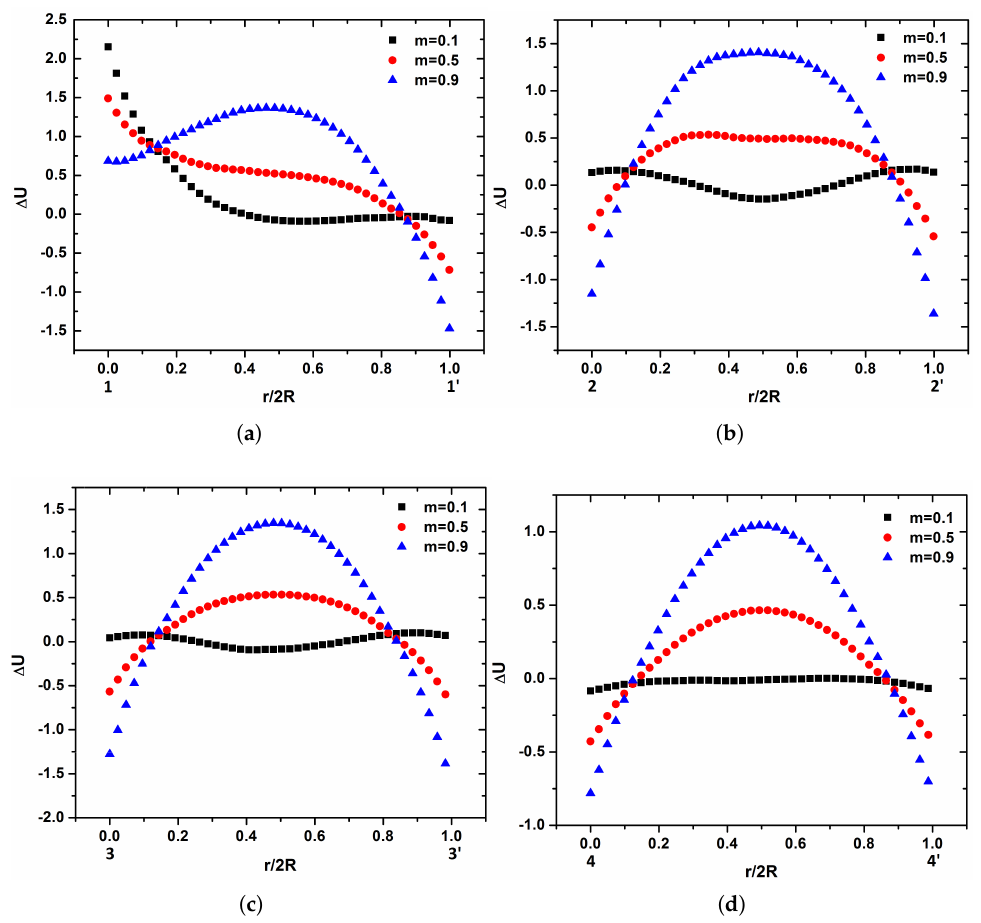
Figure 11. ∆ U along different locations in the internal carotid artery : ( a ) 11 (cid:48) , ( b ) 22 (cid:48) , ( c ) 33 (cid:48) , and ( d ) 44 (cid:48)